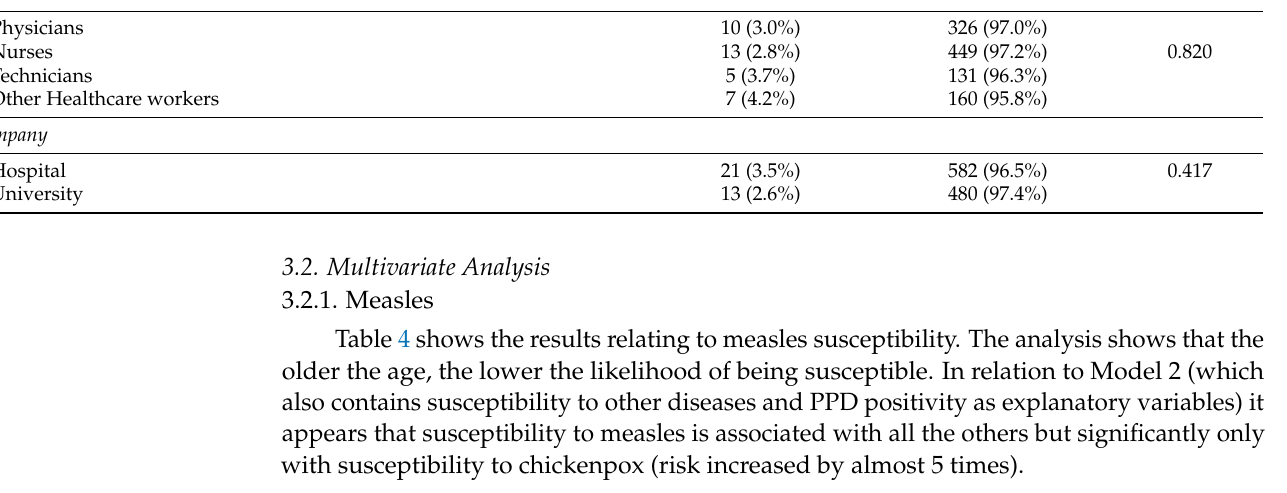
Table 4. Logistic regression analysis, dependent variable: measles